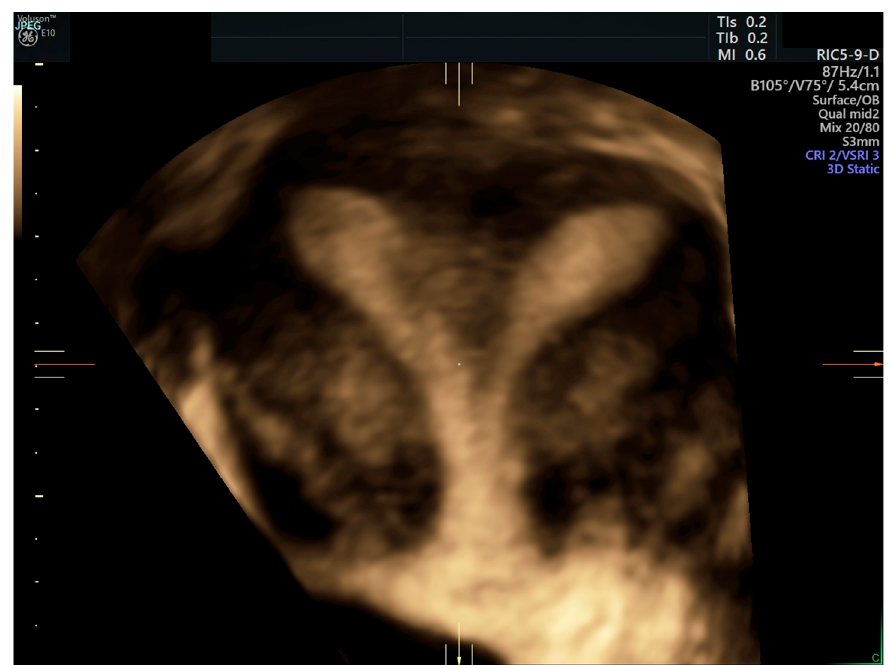
Figure 1. Uterus didelphys showing in 3D ultrasound